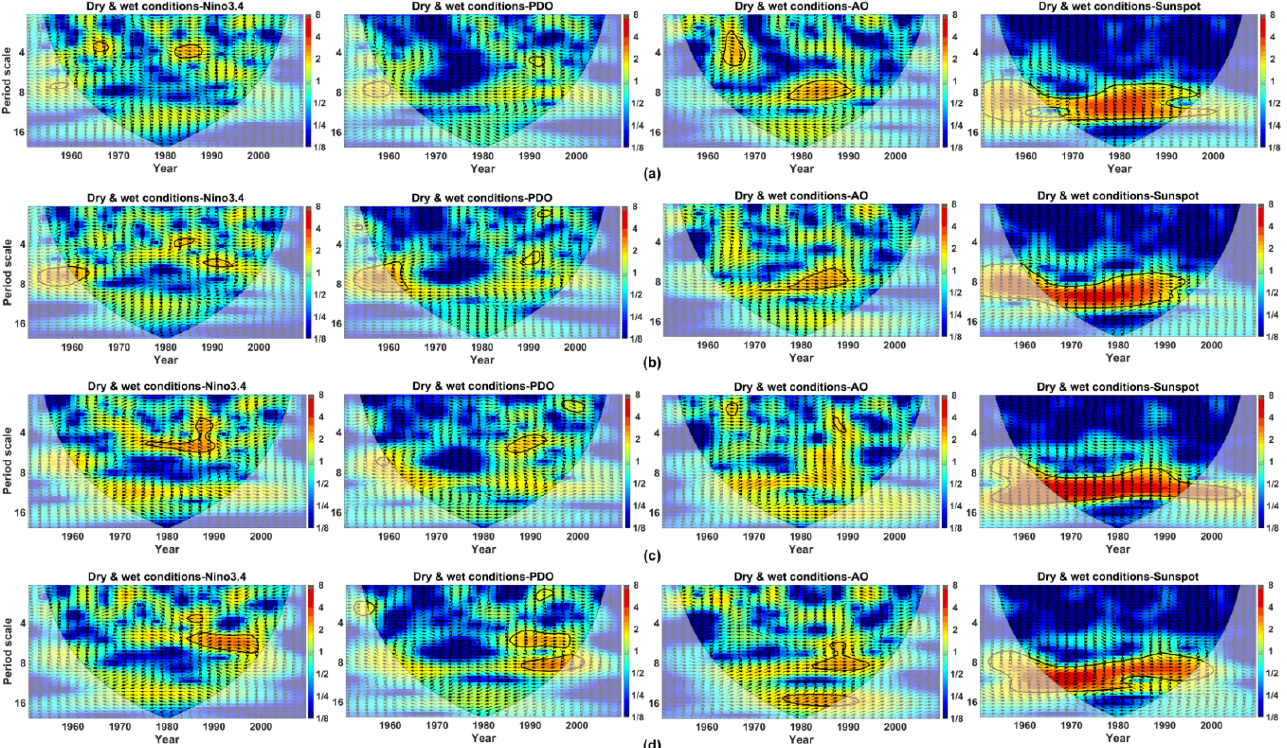
Figure 7. Cross ‐ wavelet transforms between climate indices and the MSDI series at ( a ) the upper reach of the HRB, ( b ) the Yishusi River basin, ( c ) the middle reach of the HRB and ( d ) the lower reach of the HRB. Thick contours enclose the power spectra of the cross ‐ wavelet transform which are significant against the red noise at the 5% significance level. The lighter shade indicates the cone of the influence where the boundary effect cannot be neglected.